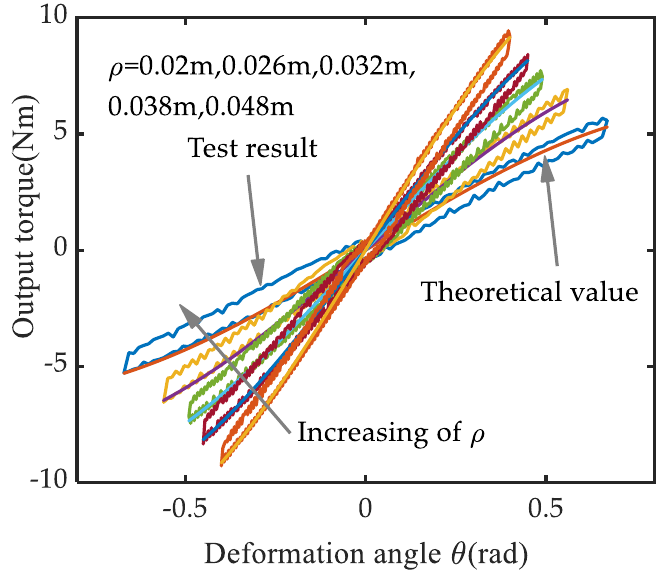
Figure 16. The force-deformation test result in the prototype.